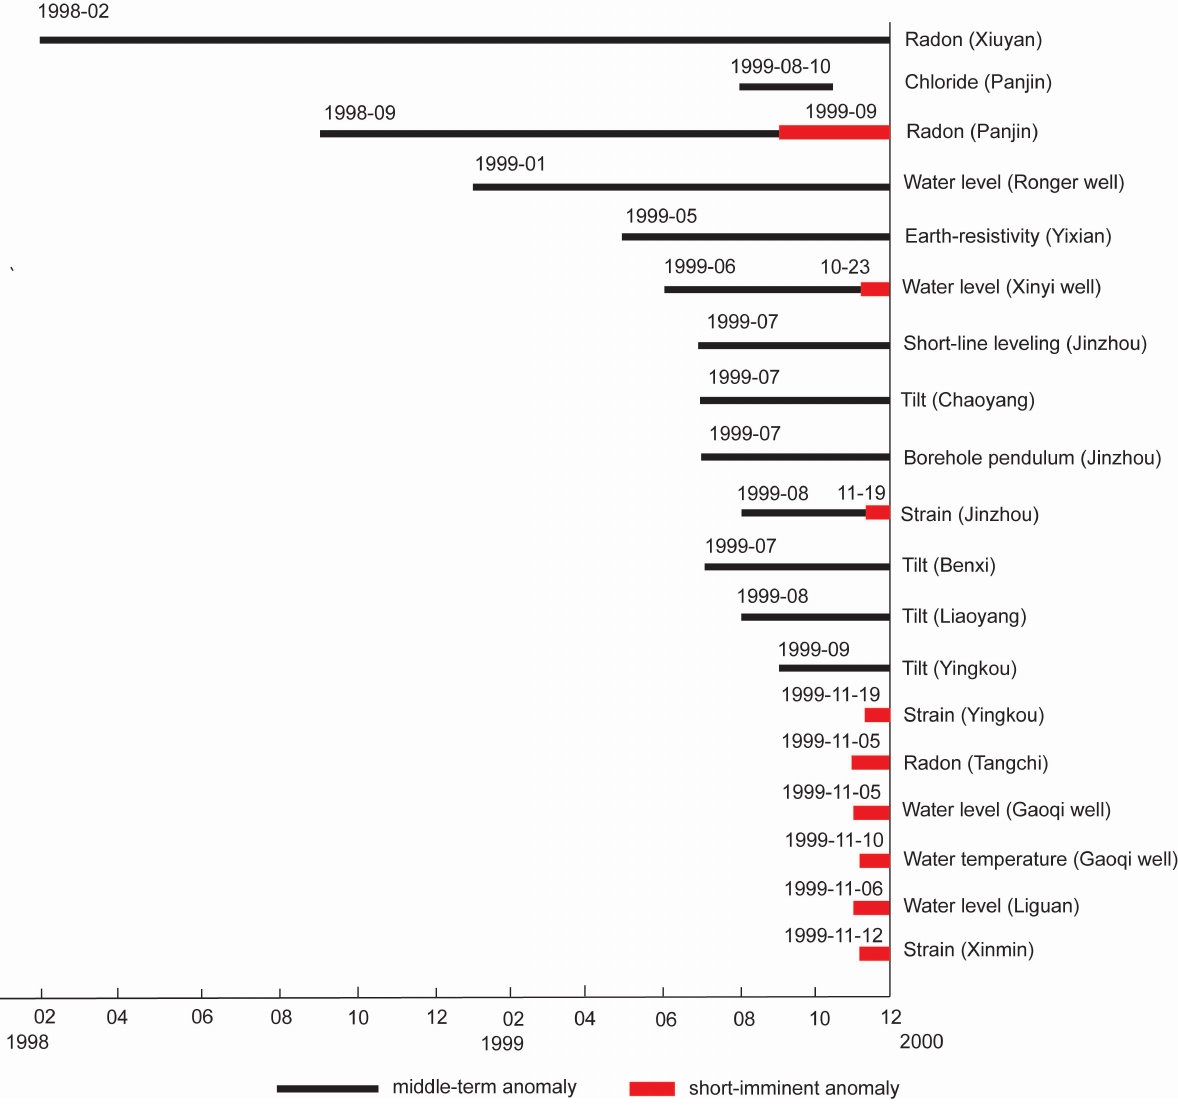
Fig. A3. Temporal process of registered precursory-like anomalies (with the name of stations in the parentheses), either by forward analysis or by retrospective analysis (based on Zhang, 2004, and the references listed in Table